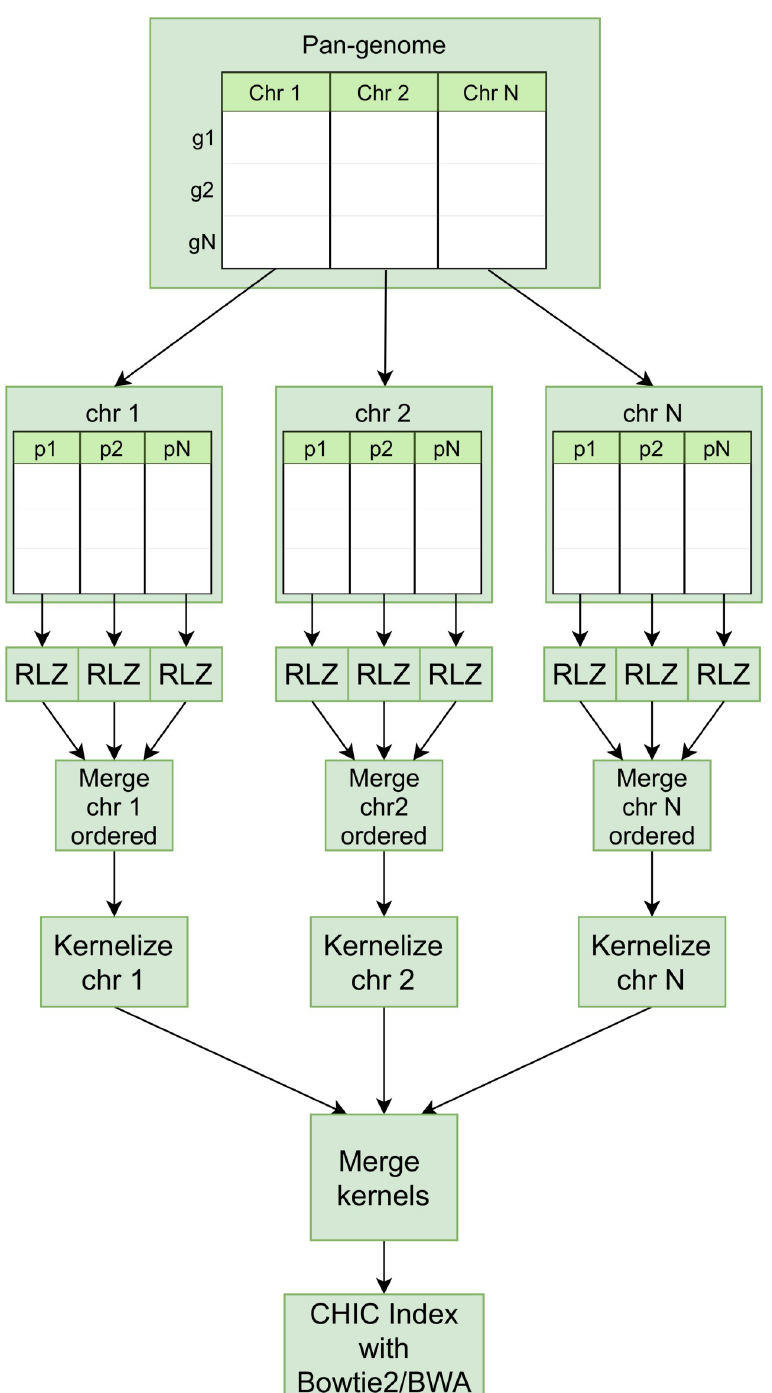
Fig 2. Distributed compression pipeline for